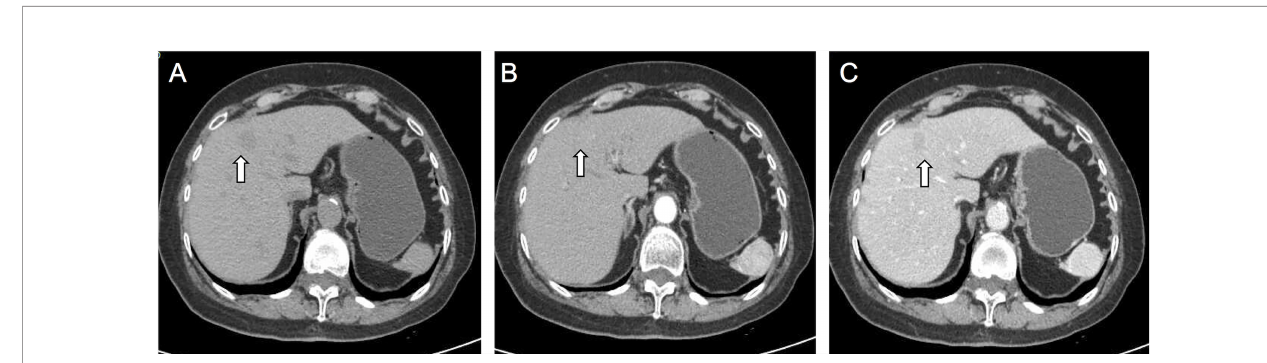
FIGURE 1 | On CT plain image, the nodule is slightly low-density lesion in the S4 of the liver (A) . On contrast-enhanced CT images, the lesion showed slight enhancement in arterial phase (B) and slight washout in portal phases (C) . The white arrow points to the lesion. Malignant tumor could not be